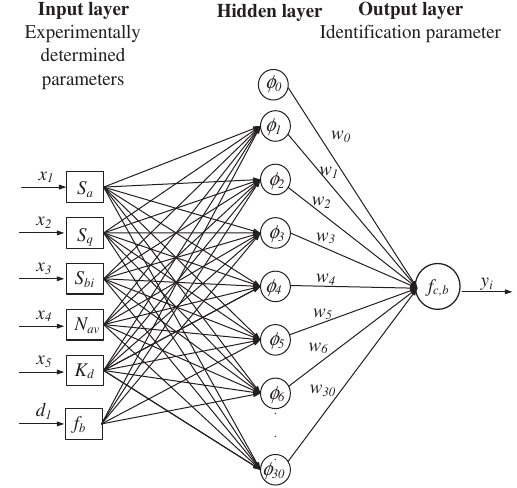
Fig. 12. Schematic of structure of RBF neural network employed for non-destructive evaluation of pull-off adhe- sion